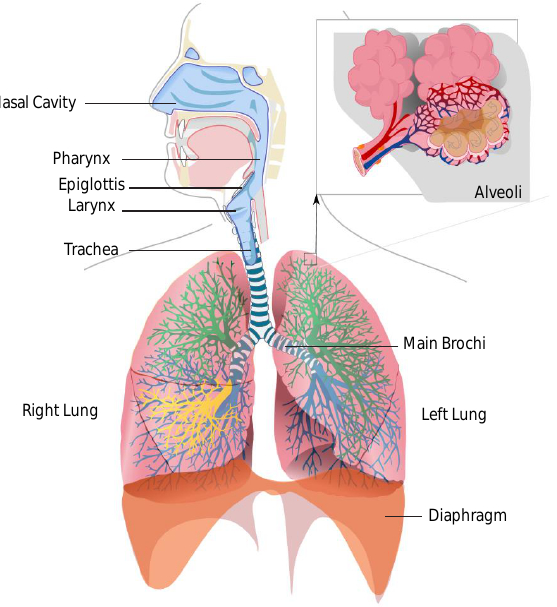
Figure 1. Basic picture of the respiratory system (Wikicommons: Respiratory).